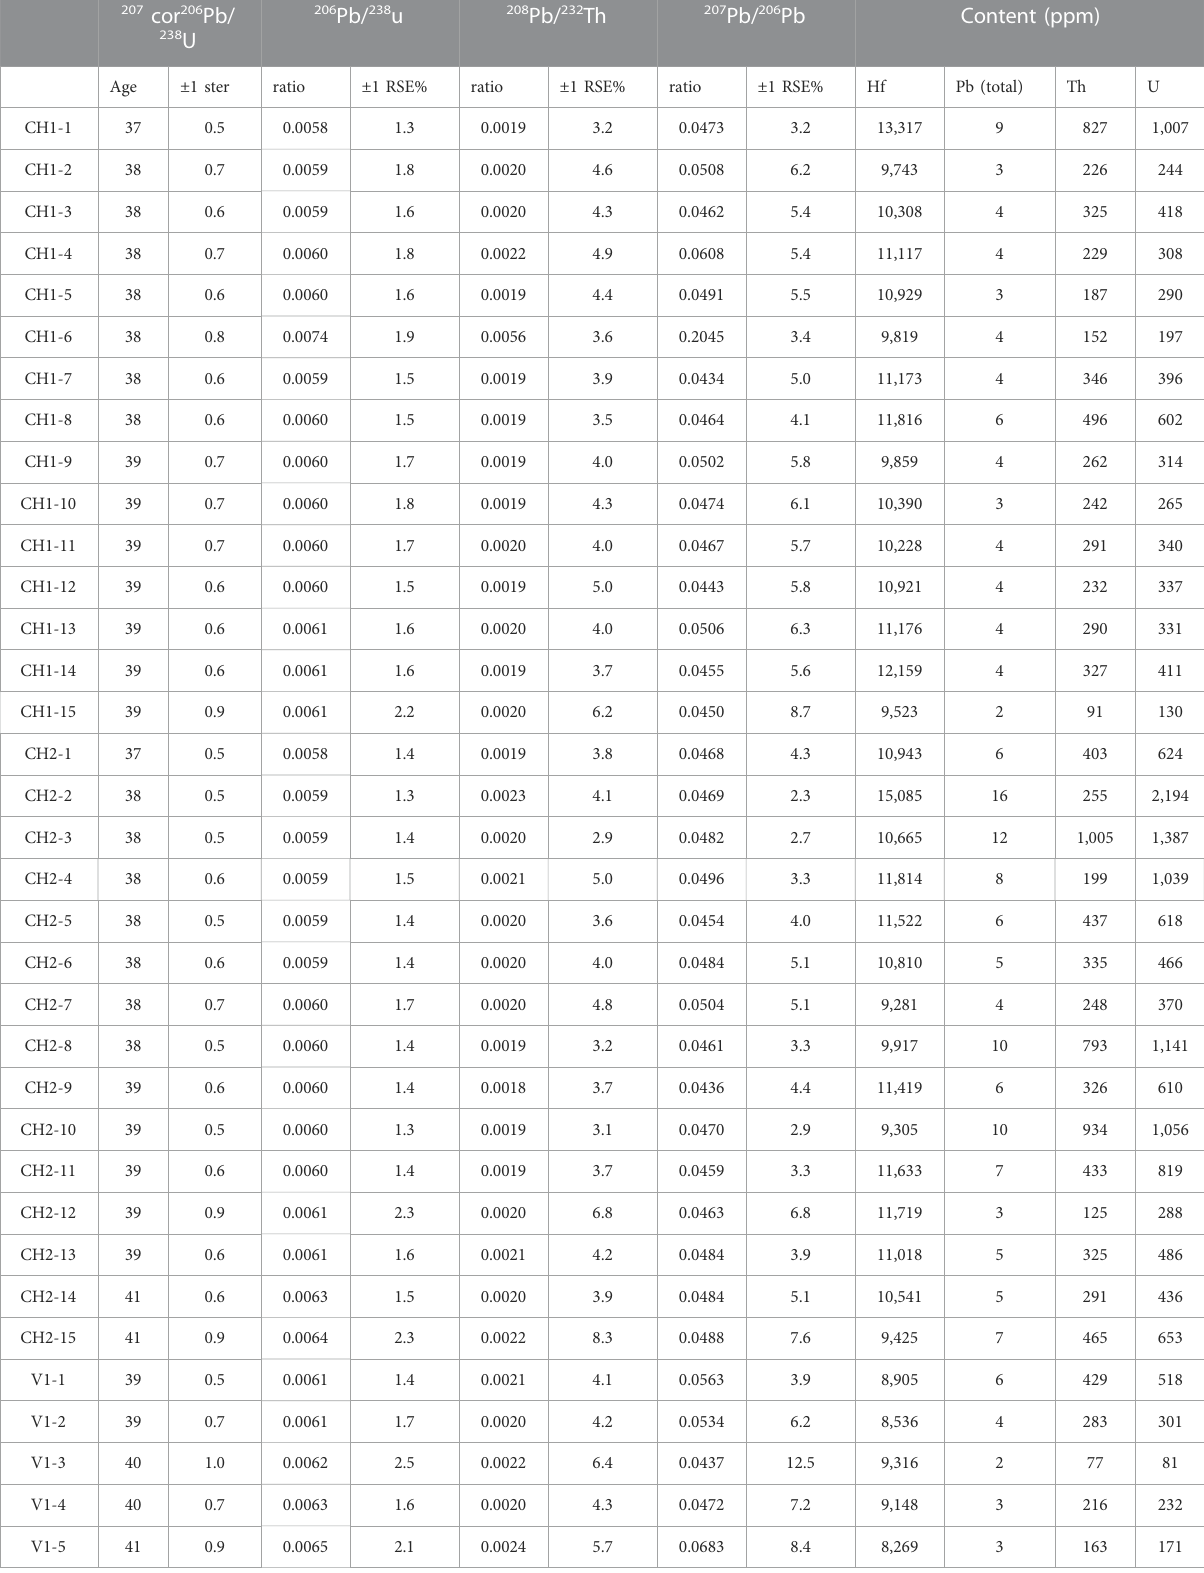
TABLE 1 LA-ICP ‒ MS zircon U – Pb age data of granitoid intrusions from the Tashvir and Varmazyar